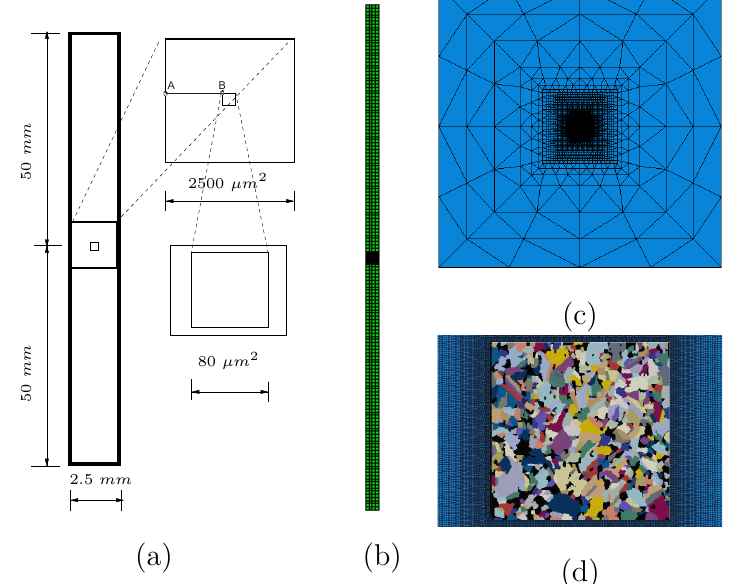
Fig. 7: (a) Dimensions of micro, macrostructures, and the tran- Figure 7. ( a ) Dimensions of micro, macrostructures, and the transition zone in the two-scale simulta- Fig. 6: The real microstruc- sition zone in the two-scale simultaneous FE simulation; (b) the neous FE simulation; ( b ) the meshing of the whole structure; ( c ) the meshing in the transition zone; ture of Fig. 2 (a) with 513 Ag ( d ) part of the meshing in the transition zone and the real microstructure with 513 Ag grains and meshing of the whole structure; (c) the meshing in the transition about 222 SnO 2 particles. grains (upper); after pixel selec- zone; (d) part of the meshing in the transition zone and the real tion (middle); selected-region microstructure with 513 Ag grains and about 222 SnO 2 particles. meshing (lower).